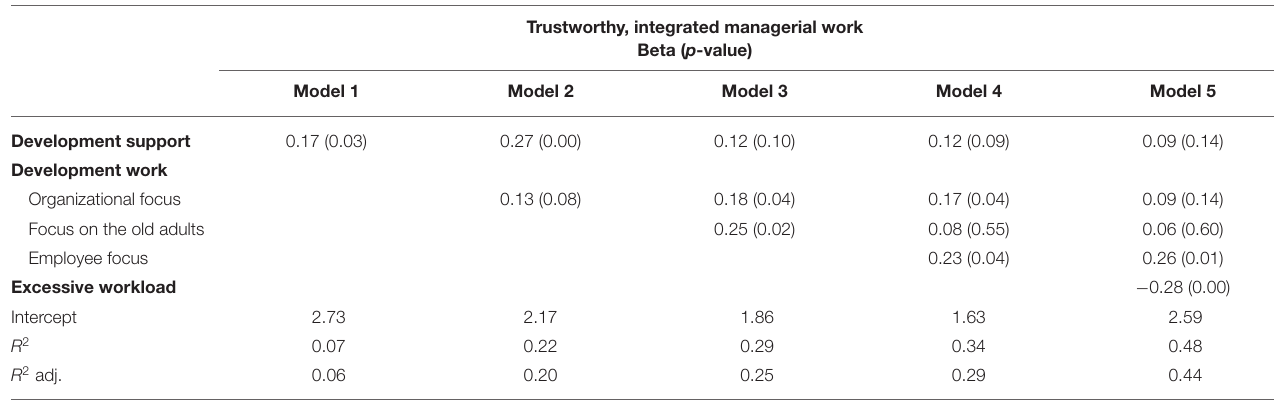
TABLE 5 | Stepwise models of the importance of FLMs’ development conditions and implemented resources for trustworthy, integrated managerial work at